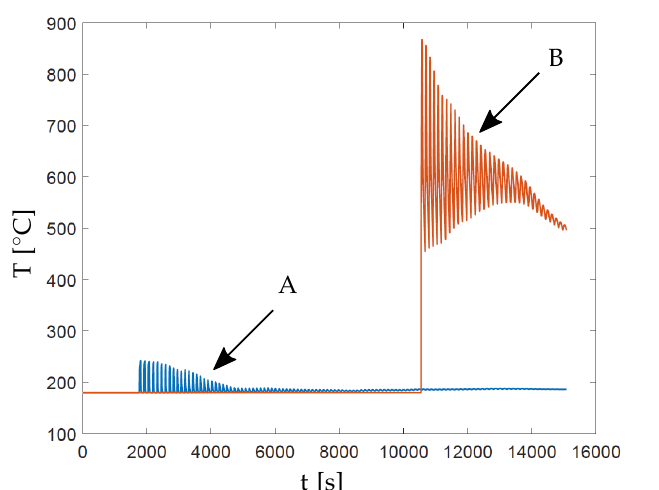
Figure 5. Variation of temperatures with respect to time for the node located at Points A and B in Figure 3b. Temperatures are calculated using the described transient thermal model of the LPBF